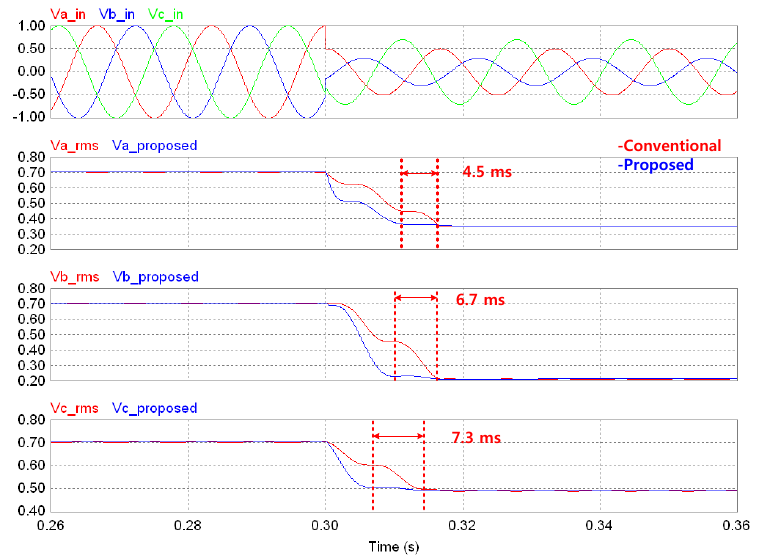
Figure 9. Simulation results of proposed